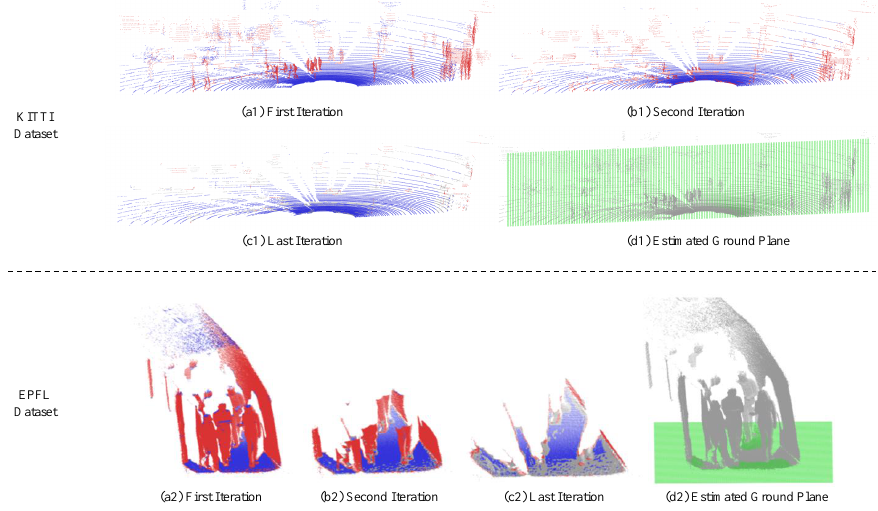
Figure 4. The iterative processes of our improved gravity direction estimation on the KITTI and EPFL